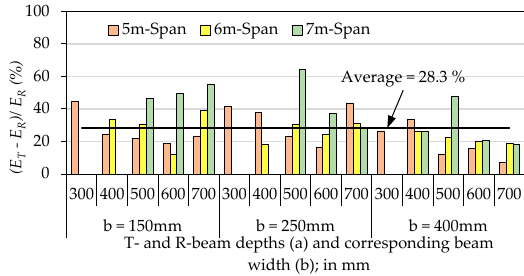
Figure 8. The impact of slab presence on energy dissipation.